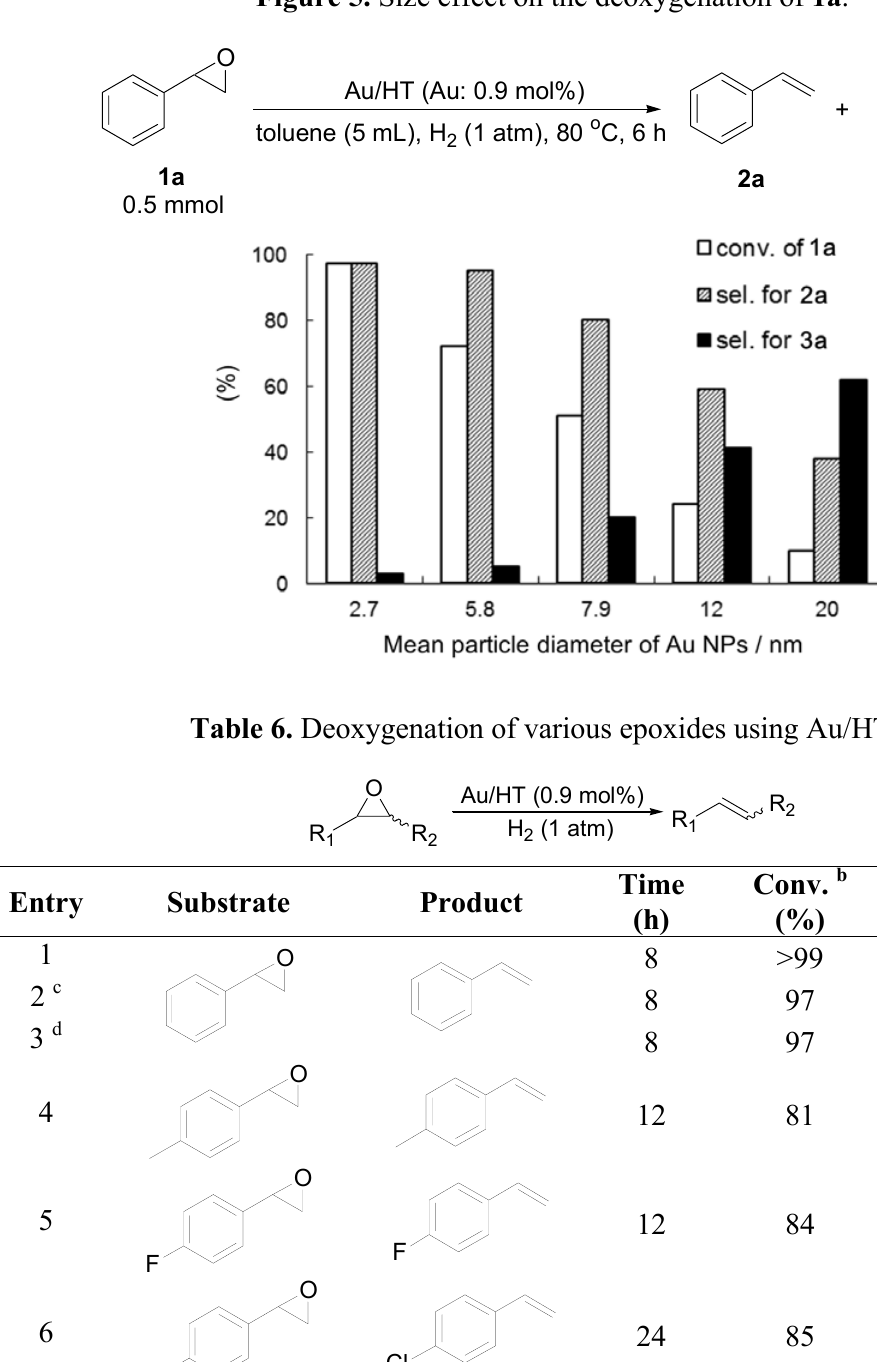
Figure 5. Size effect on the deoxygenation of 1a .